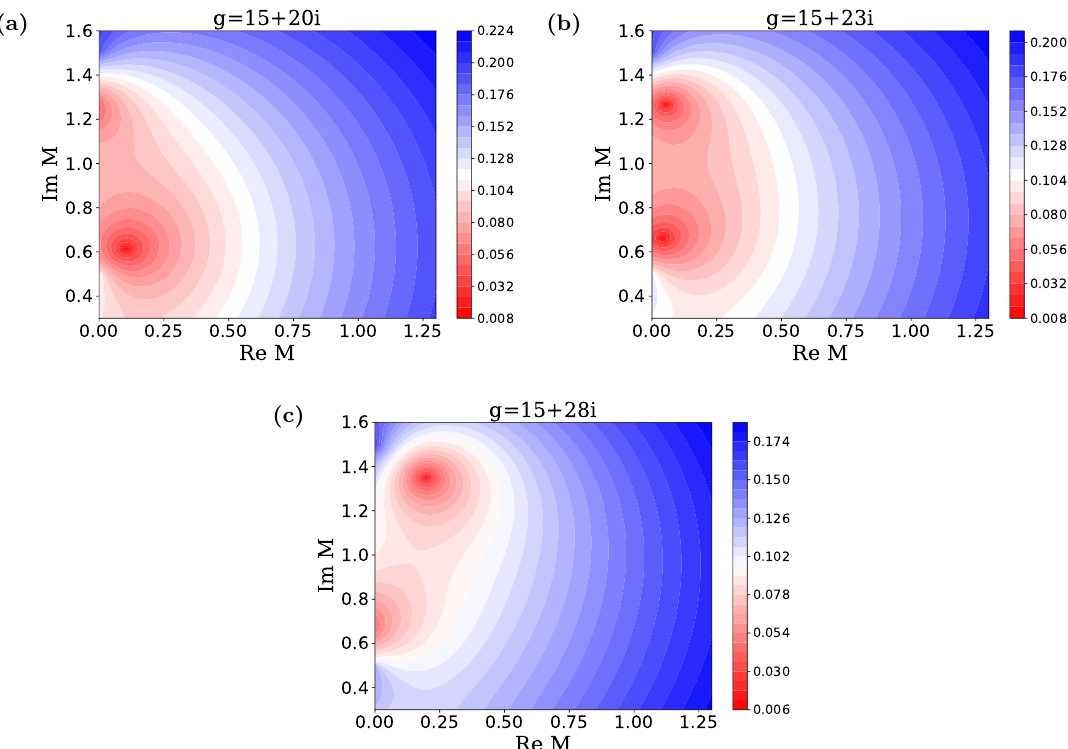
p Figure 3. | ∂S/∂M | on the complex M plane at